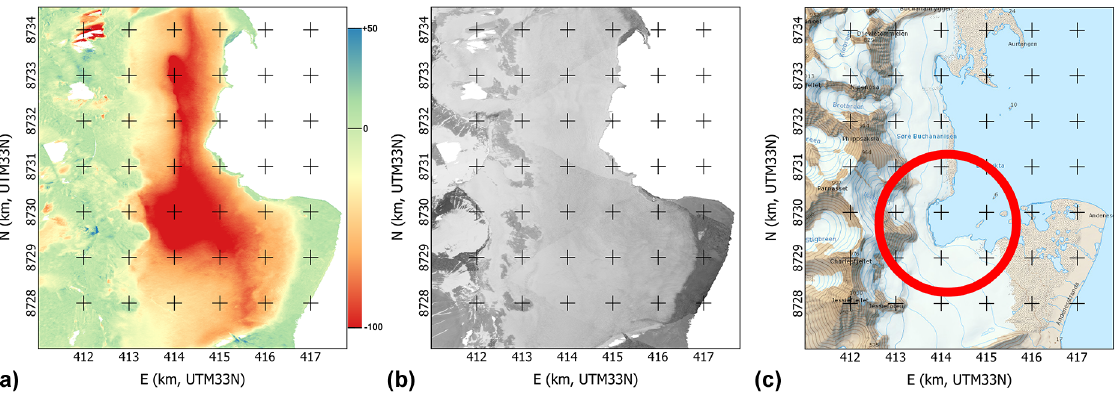
Figure 10. Data over Søre Buchananisen. (a) dDEM between our 1936 and the NPI 2008 DEM. (b) Orthoimage from the 1936 data. (c) Map by NPI made using the 2008 data (rectangular indent circled in